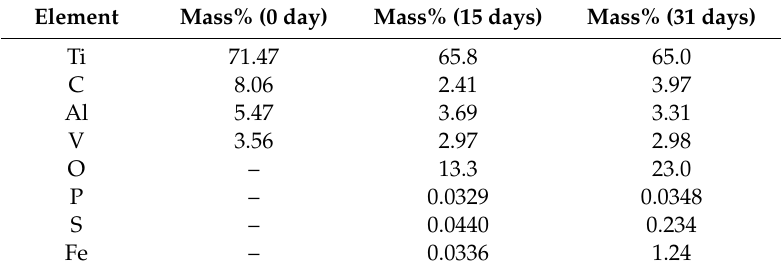
Table 4. The result of X-ray fluorescence.